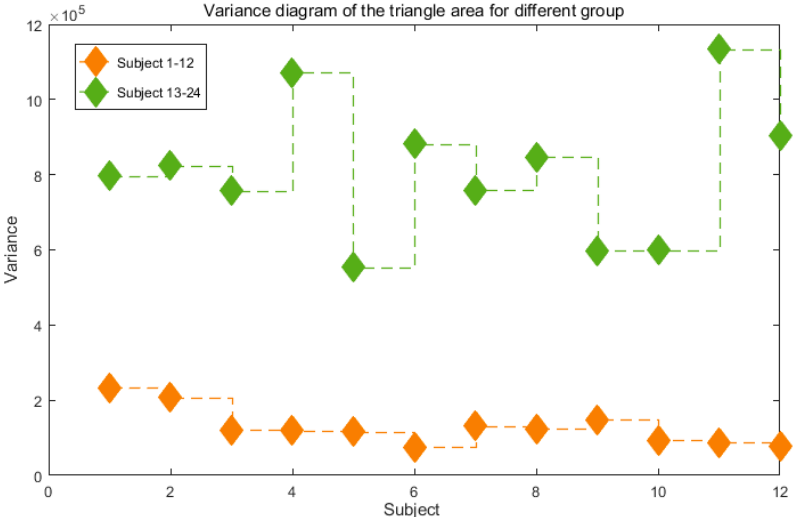
Figure 5. comparison of multi-barycentric area for different people.